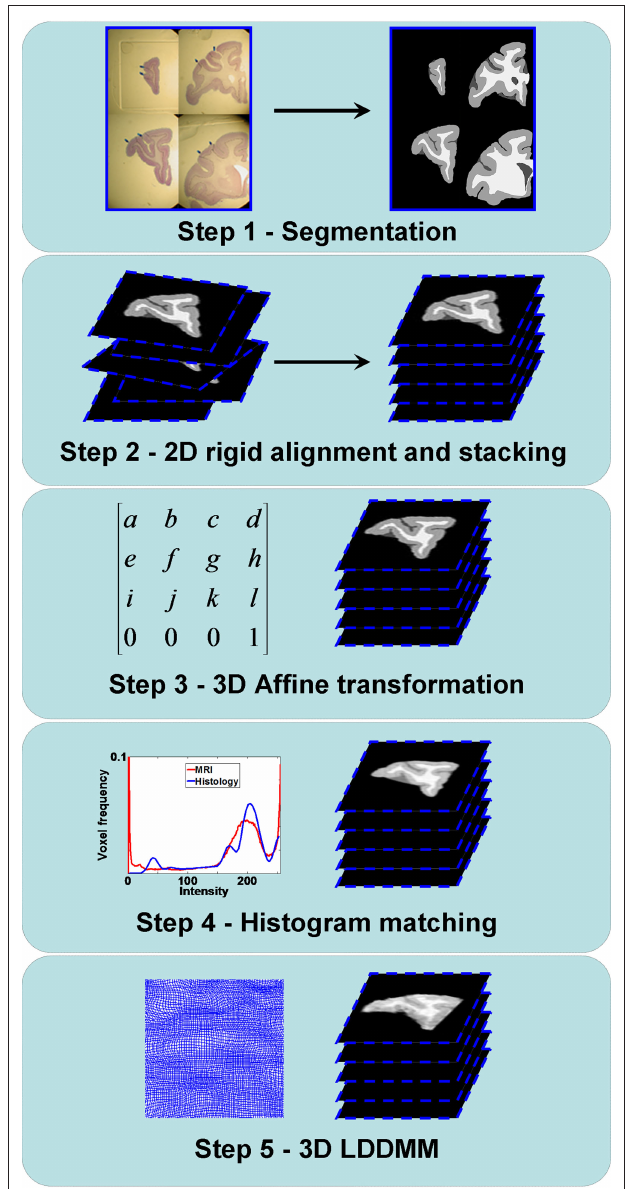
FIguRe 1 | Flowchart illustrating the registration steps from the histology to the MRI volumes. Step 1: GM/WM/CSF segmentation of the histological sections. Step 2: 2D rigid alignment and stacking of histological sections. Step 3: 3D affine registration of the 3D histological image to the MRI volume. Step 4: Histogram matching between the 3D histological image and the MRI volume. Step 5: 3D LDDMM image matching between the 3D histological image and the MRI